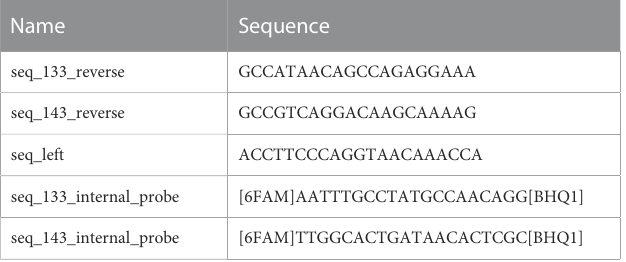
TABLE 2 Primers and Taqman probes for Taqman assay.